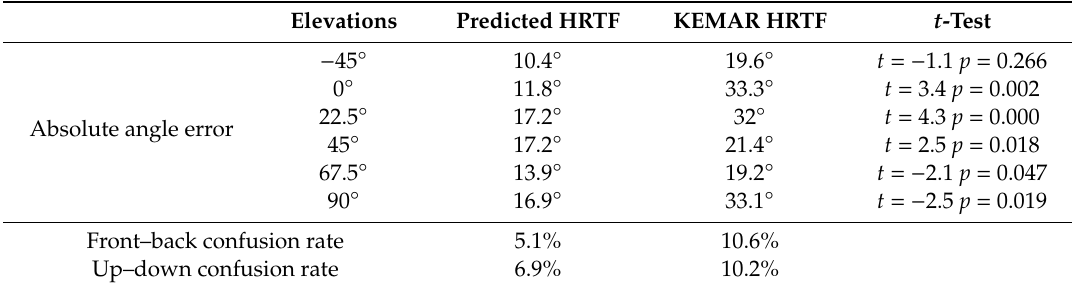
Table 7. Results of the localization experiment and corresponding statistical